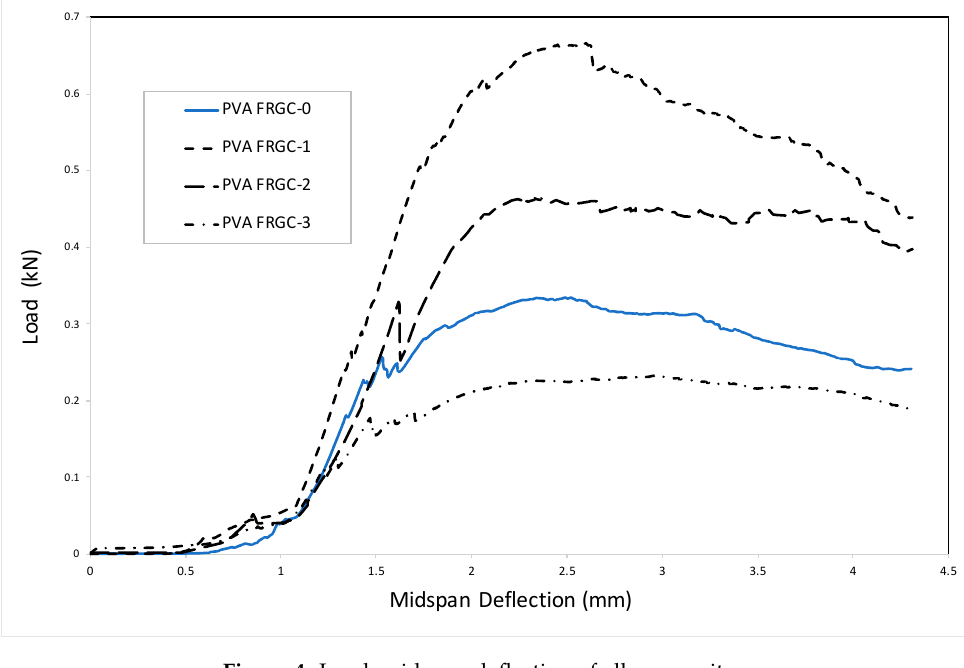
Figure 4. Load–midspan deflection of all composites.